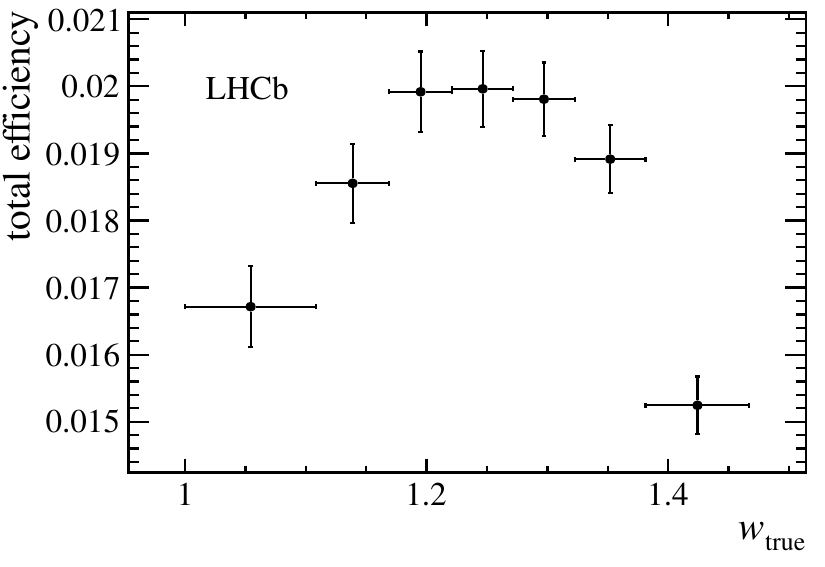
Figure 7 . Total efficiency as a function of w true , including the acceptance of the LHCb detector as well as the reconstruction and selection